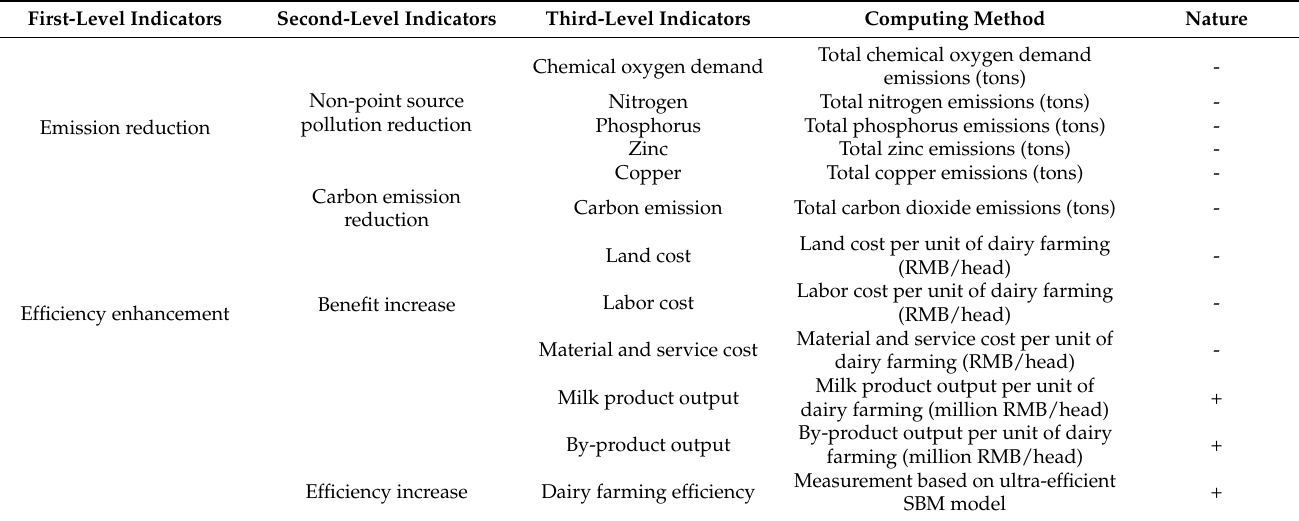
Table 1. Evaluation index system for green transformation of dairy farming subject